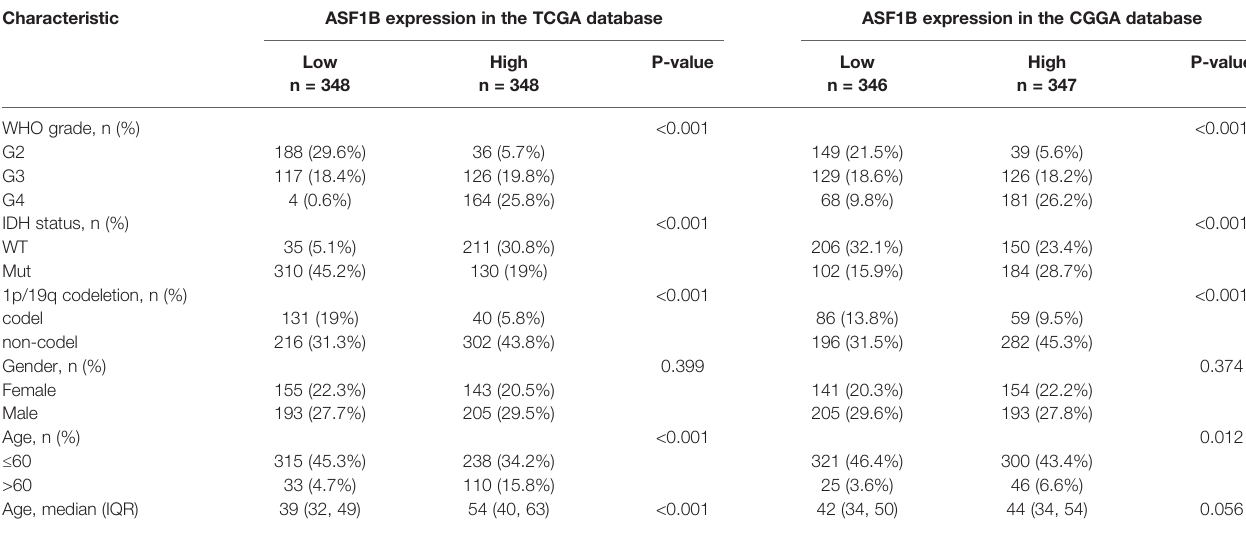
TABLE 2 | Association of ASF1B expression and clinicopathological parameters in patients with gliomas. Characteristic